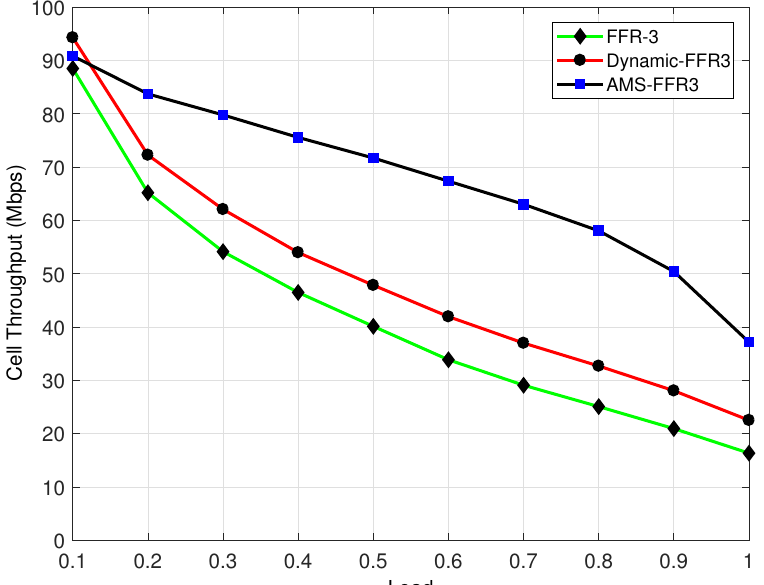
Figure 8. Achievable throughput with respect to